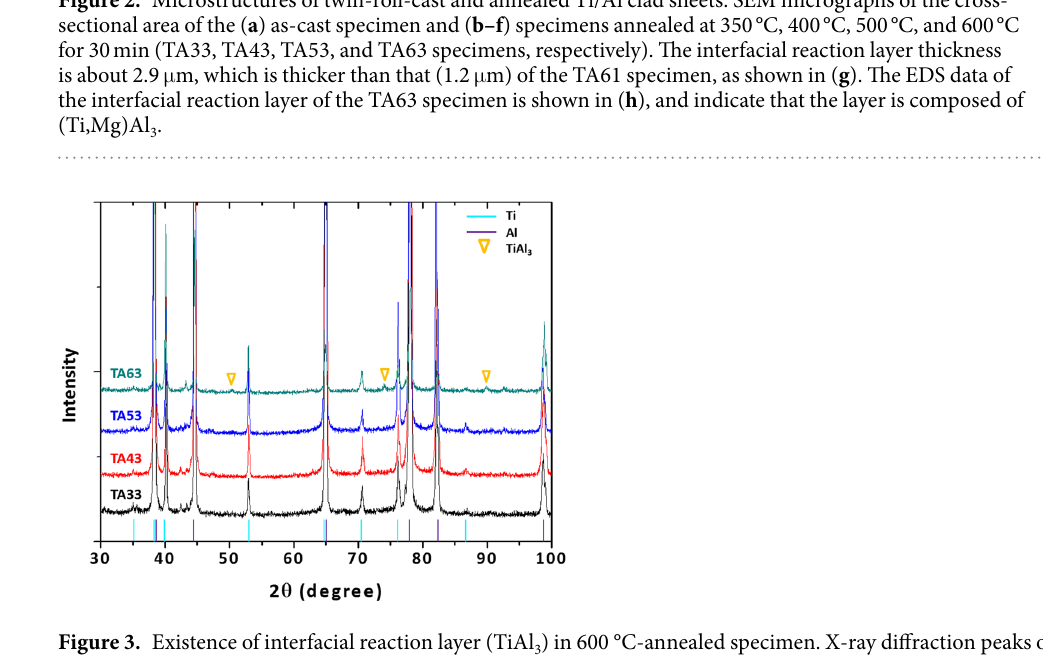
and tensile strengths are similar to those of the 400 °C-annealing specimens, and the elongation increases with increasing annealing time (Fig. 3(c)). Overall tensile properties and stress-strain curve shapes of the TA61 spec- imen are similar to those of the TA36 or TA43 specimen, but the elongation is seriously reduced to 17% in the TA63 specimen (Fig. 3(d)). The TA31and TA66 specimens are not tensile-tested because it is easily expected that